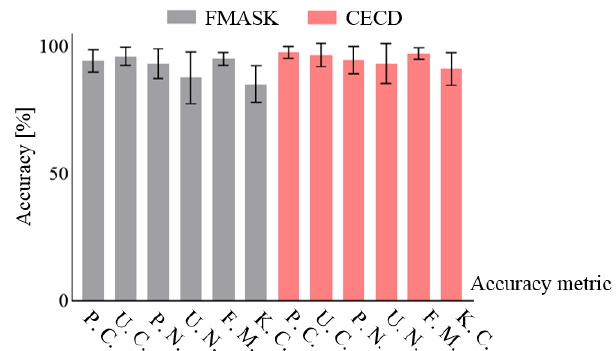
Figure 8. A bar graph plot of the average cloud detection accuracy obtained using FMASK and CECD for the 14 selected L8_Biome images with standard deviation error bars. Noted: F. M., F-Measure; P. C., producer’s accuracy for cloud; U. C., user’s accuracy for cloud; P. N., producer’s accuracy of non-cloud; U. N.,